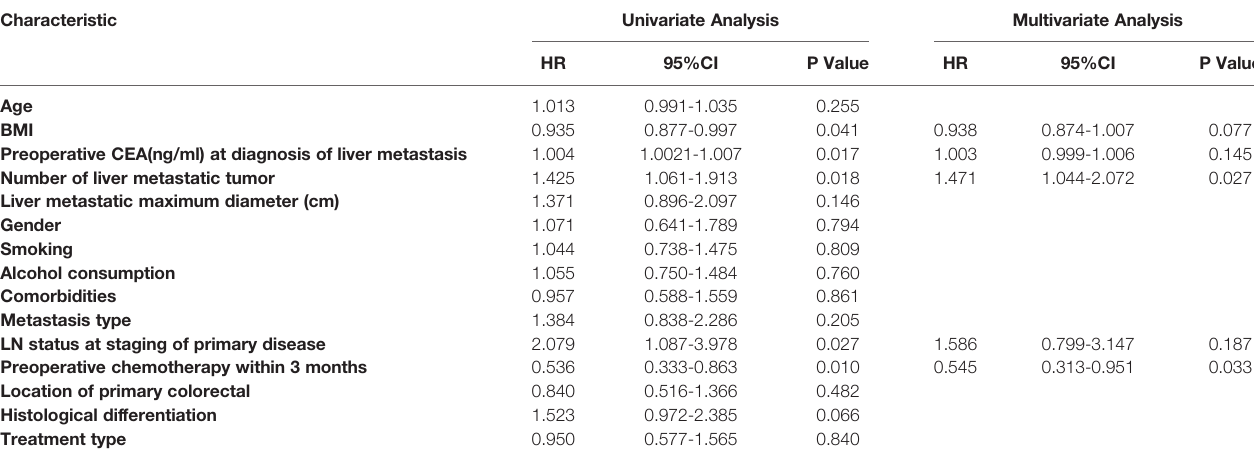
TABLE 3 | Cox Survival Analysis of Predictors OS in the Whole Population.